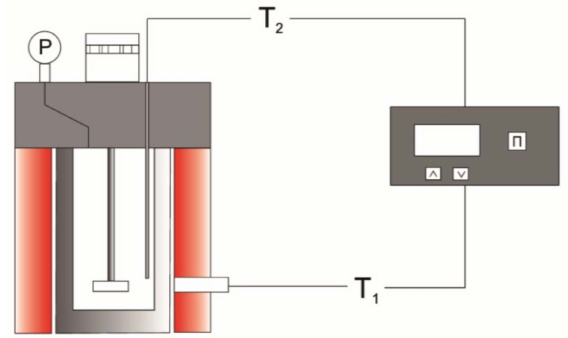
Figure 7. Schematic diagram of an oil-cracking unit.